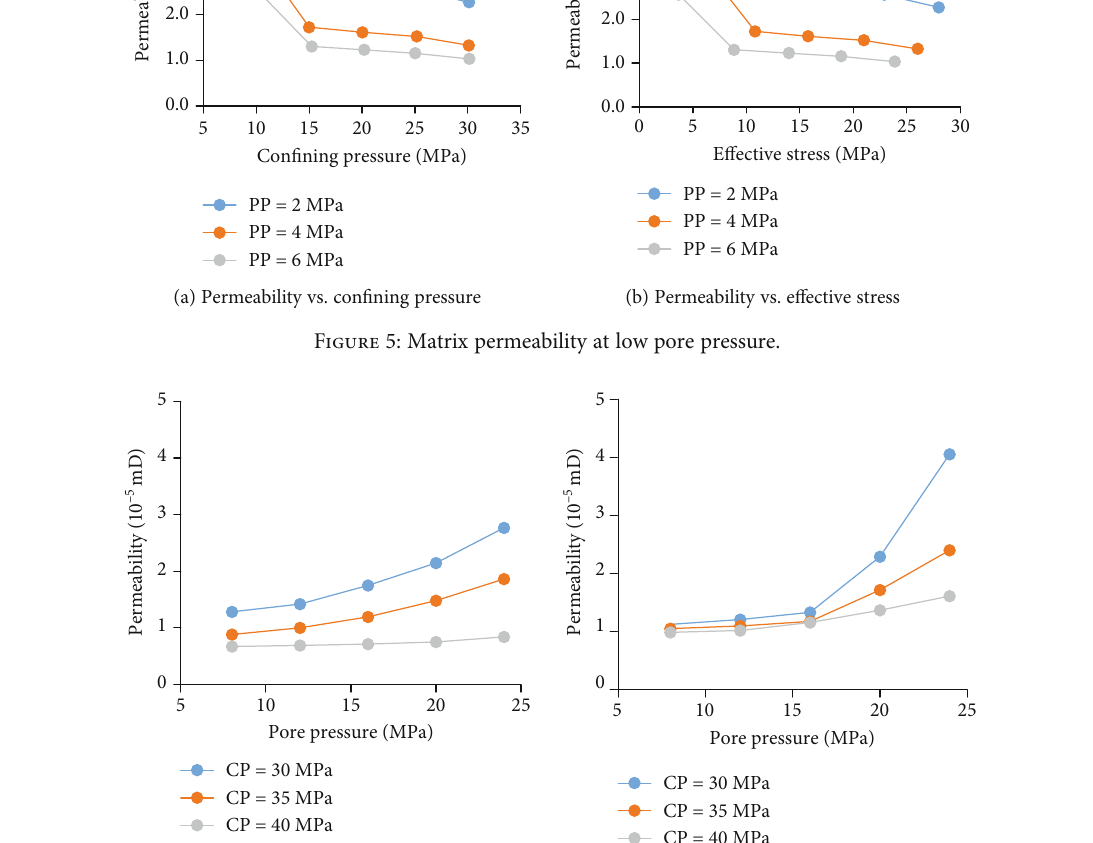
Figure 6: Relationship between permeability and pore